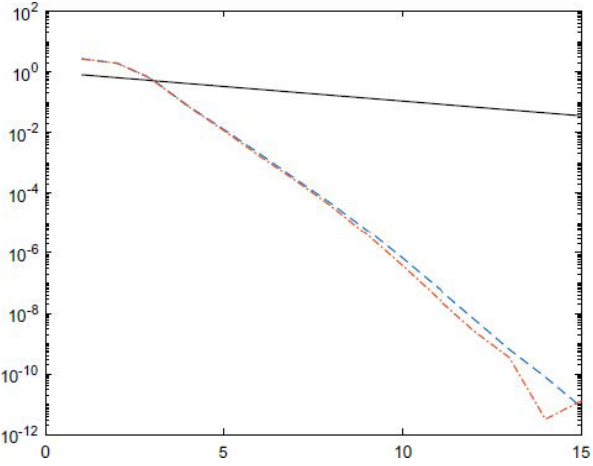
Fig. 9 Step response of CFE-Al-Alaoui discrete method. CFE, continued fraction